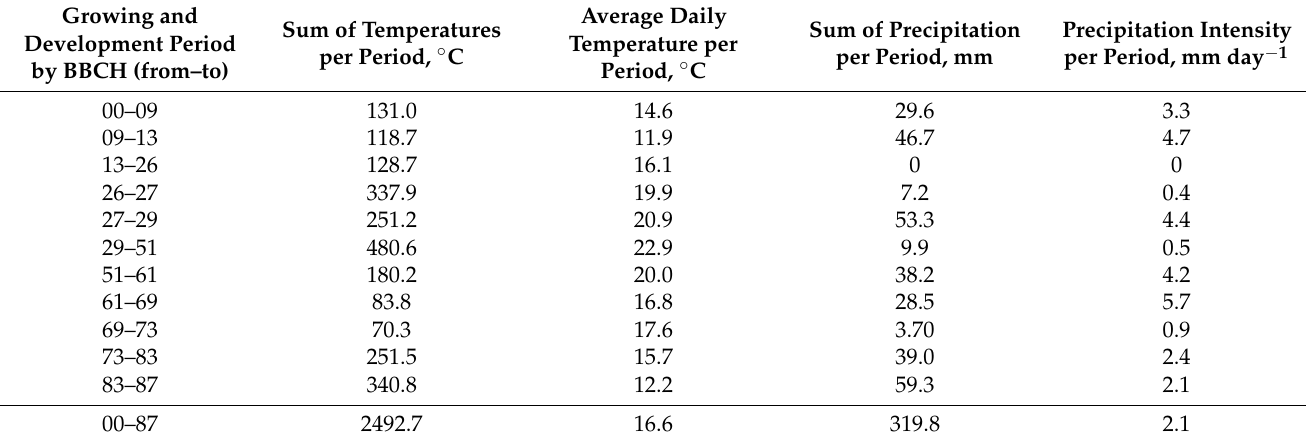
Table 5. Meteorological conditions (air temperature and precipitation) during the maize growing season in